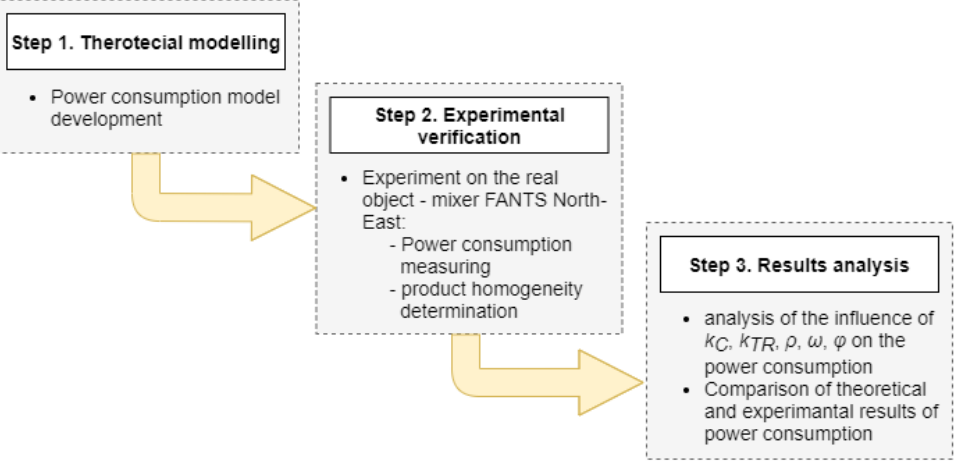
Figure 1. A scheme of procedures used in the study, k C is the coefficient of friction between material grains; k TR is the coefficient of friction between material and steel; ρ is the screw radius; ω is the screw angular speed; ϕ is the angle of interaction of screw with the material.